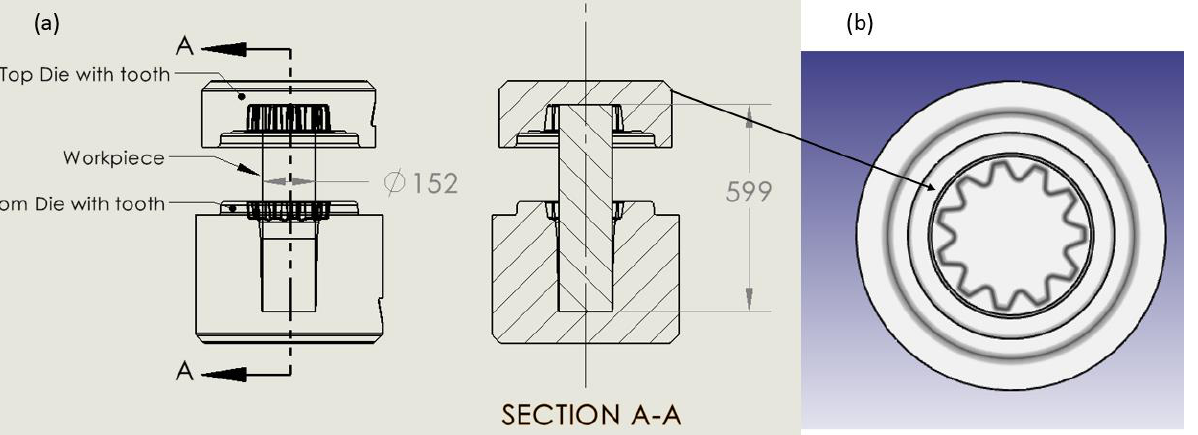
Figure 15. ( a ) Schematics of near-net-shape forging, ( b ) Top die with gear teeth and punch. Di- mensions in mm.